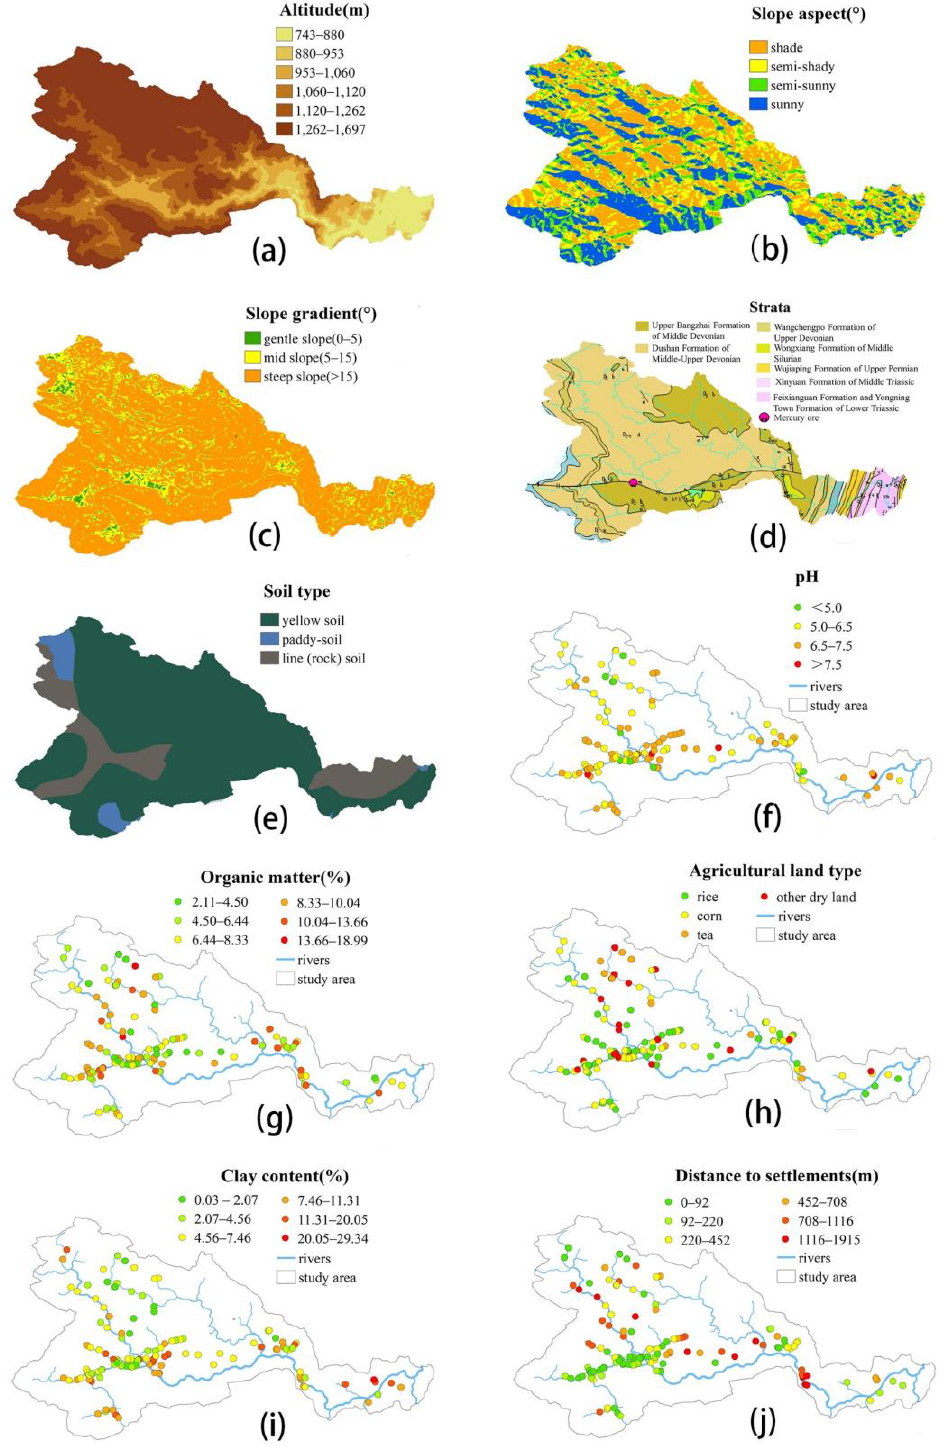
Figure 2. The maps of the impact factors in the soils of the Caidi River watershed, Guizhou Province, including altitude ( a ), slope aspect ( b ), slope gradient ( c ), strata ( d ), soil type ( e ), pH ( f ), organic matter ( g ), clay content ( h ), agricultural land type ( i ) and distance to settlements ( j ).